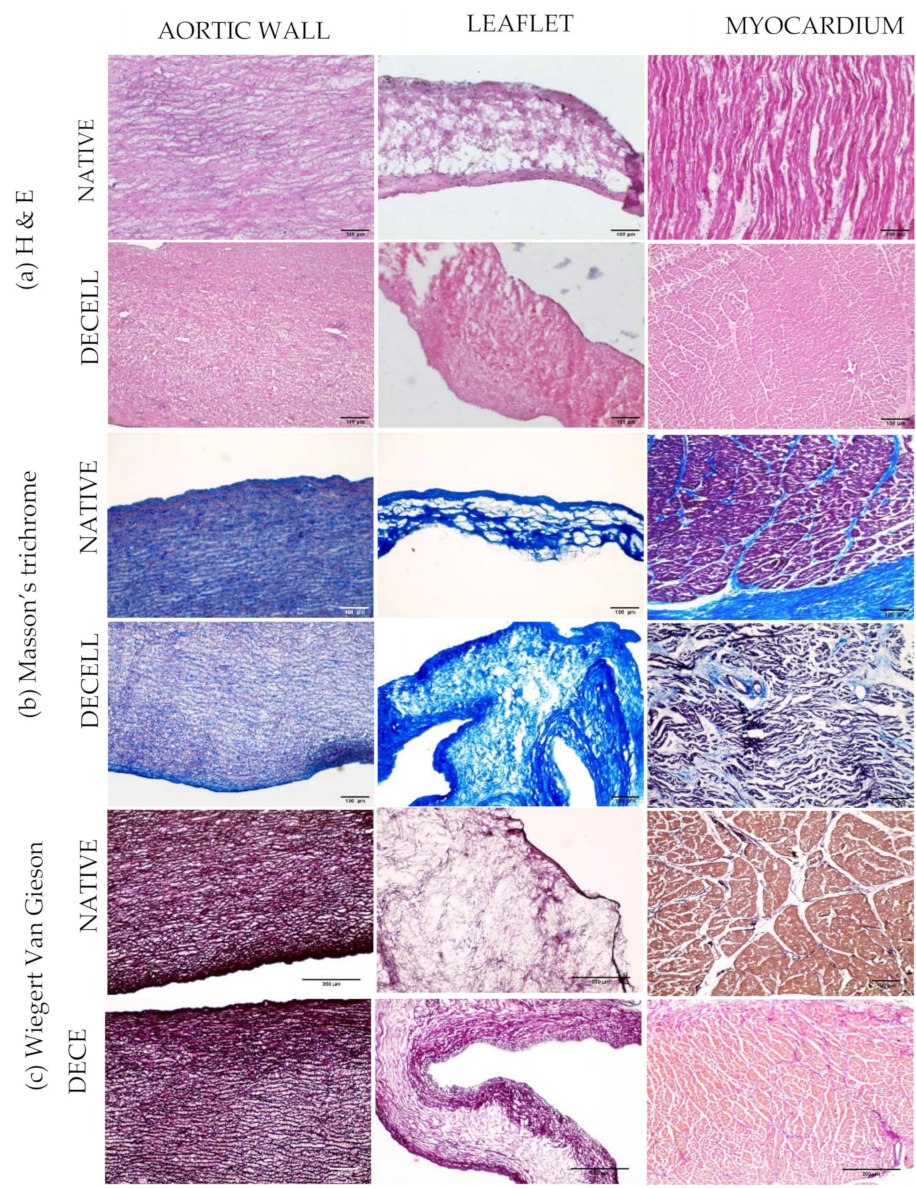
Figure 4. Histological analysis of native and decellularized tissues was performed on OCT embedded cryosections (7 µ m). ( a ) Hematoxylin and Eosin staining showed the presence of nuclei in native aortic wall, leaflet, and myocardium and the removal of nuclei in the decellularized counterparts. ( b ) Masson’s trichrome showed the nuclei in black staining aligned with collagen in blue. ( c ) Wiegert Van Gieson staining indicates the presence of nuclei in native tissues (elastin and collagen are in red) while nuclei are absent in the decellularized